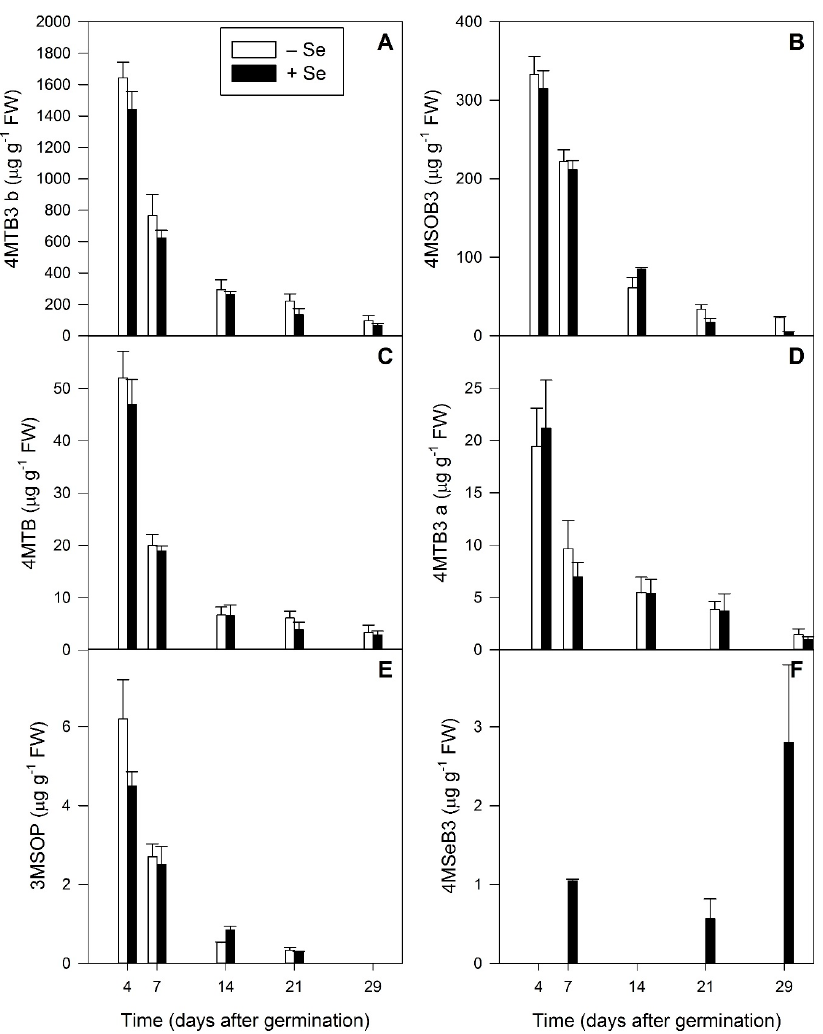
Figure 6. Aliphatic glucosinolates detected using LC-MS analysis of five developmental stages (4, 7, 14, 21 and 29 days after germination) of Raphanus sativus plants grown hydroponically in the absence (white bars) and presence (black bars) of 40 µM sodium selenate. Each bar represents the mean value of three biological replicates, n = 3. Error bars represent the standard error of the mean. ( A ) 4MTB3 b: 4-(methylthio)but-3-enyl isomer b, ( B ) 4MSOB3: 4-(methylsulfinyl)but-3-enyl, ( C ) 4MTB: 4-(methylthio)butyl, ( D ) 4MTB3 a: 4-(methylthio)but-3-enyl isomer a, ( E ) 3MSOP: 3-(methylsulfinyl)propyl, ( F ) 4MSeB3: 4-(methylseleno)but-3-enyl.